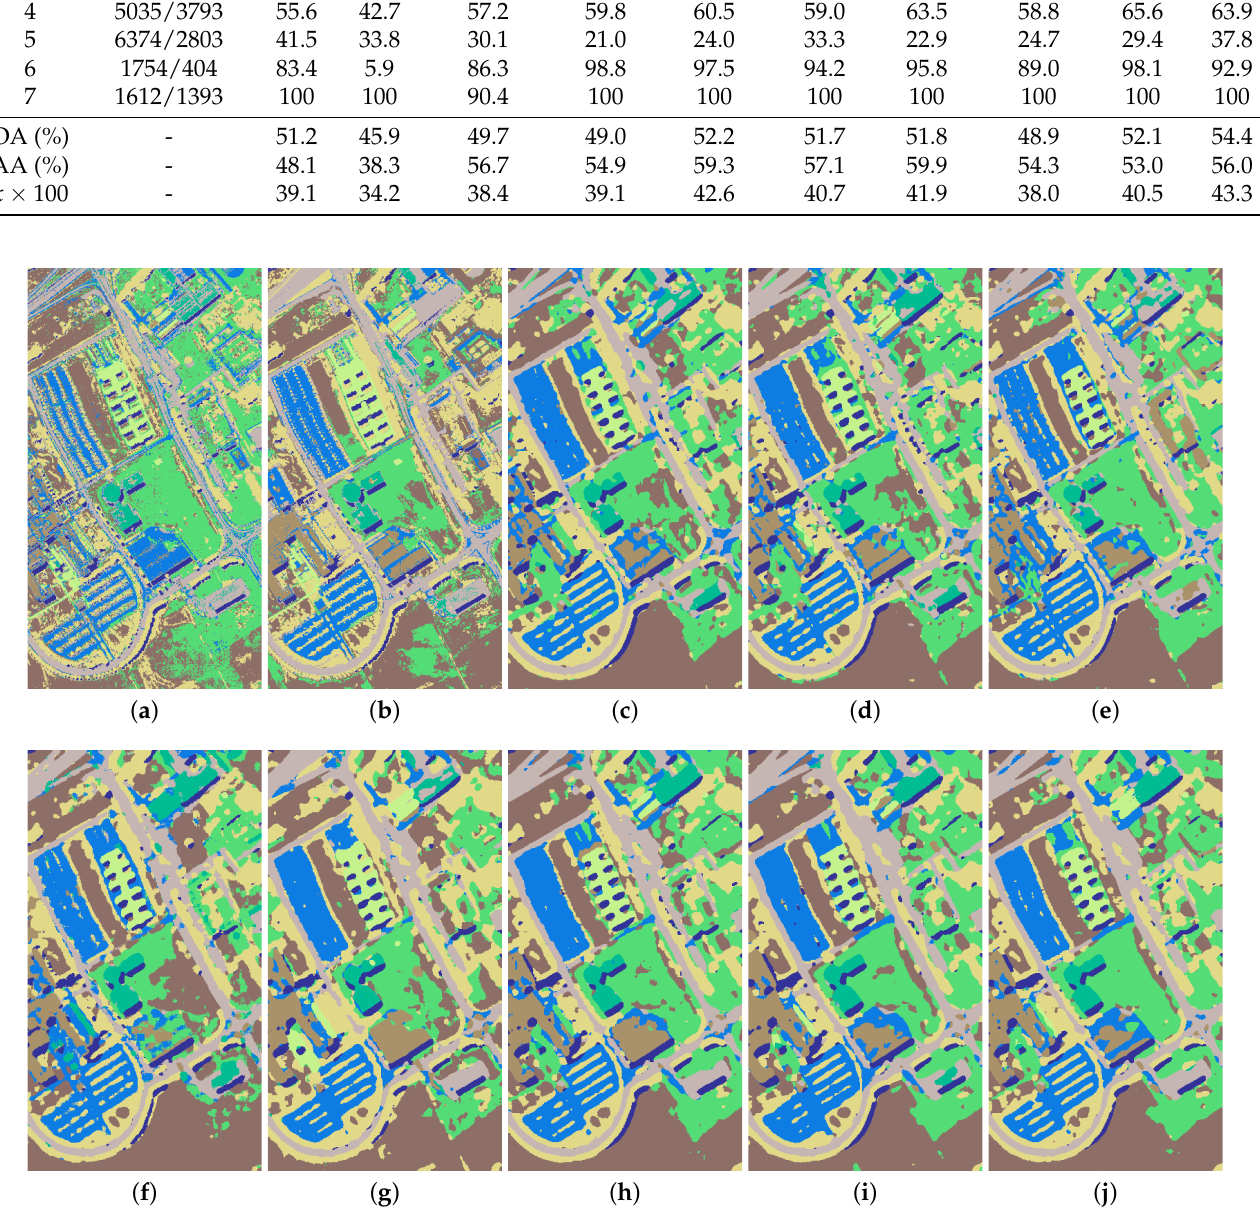
Figure 13. Classification maps for the UP dataset. ( a ) SVM (OA = 80.0%). ( b ) EMP (OA = 83.2%). ( c ) DenseNet (OA = 91.6%). ( d ) DPRN (OA = 92.1%). ( e ) FDMFN (OA = 92.8%). ( f ) MSRN (OA = 90.6%). ( g ) LWRN (OA = 93.4%). ( h ) SSSERN (OA = 94.4%). ( i ) DRN (OA = 95.9%). ( j ) Proposed DRIN (OA =